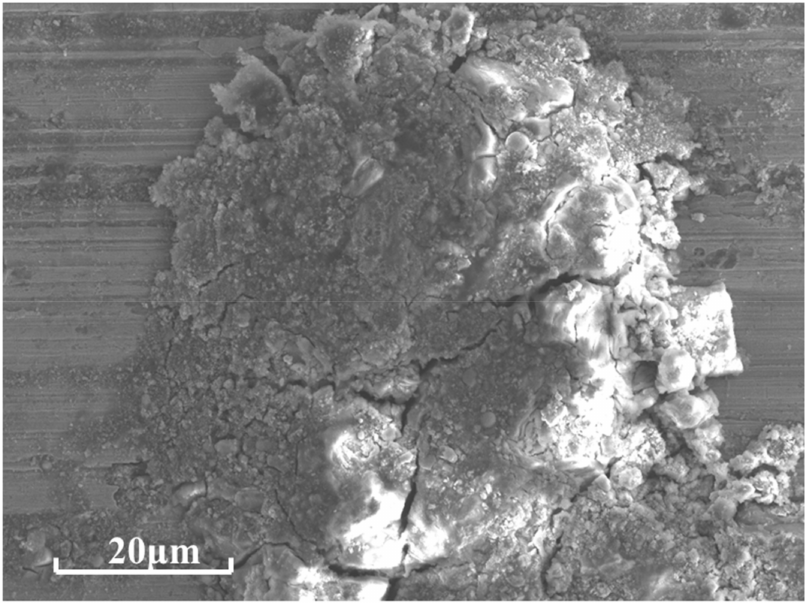
Figure 15. Broken passivation coating of NiO and Cr 2 O 3 corrosion